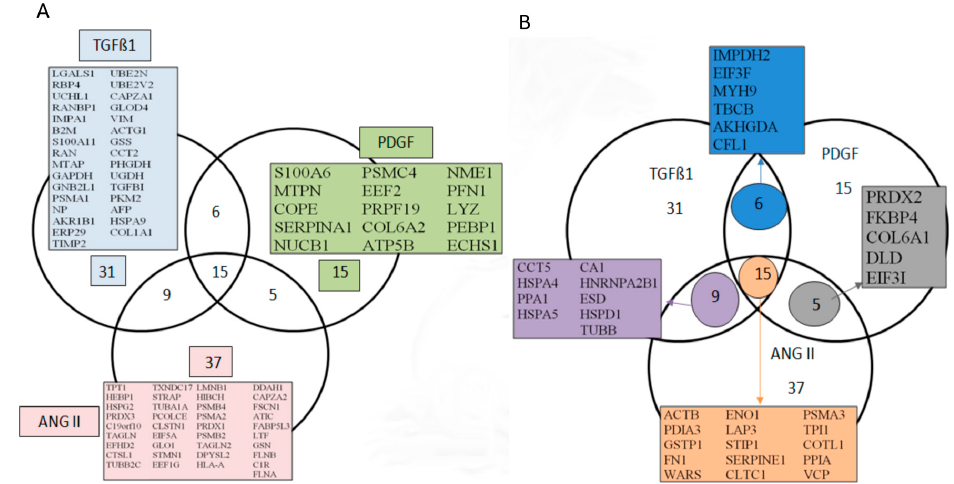
Figure1. Mappingrenalfibroblasts(TK173)secretomeafterstimulationwithtransforminggrowthfactor beta 1 (TGF β 1), Angiotensin II (ANG II), and Platelet-derived growth factor (PDGF). Venn